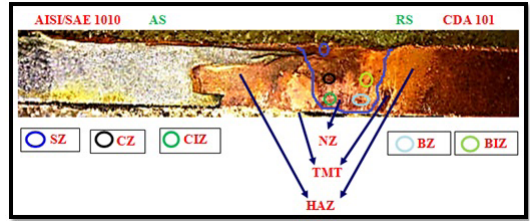
Figure 5. The macropattern of the weld joint b/w copper and